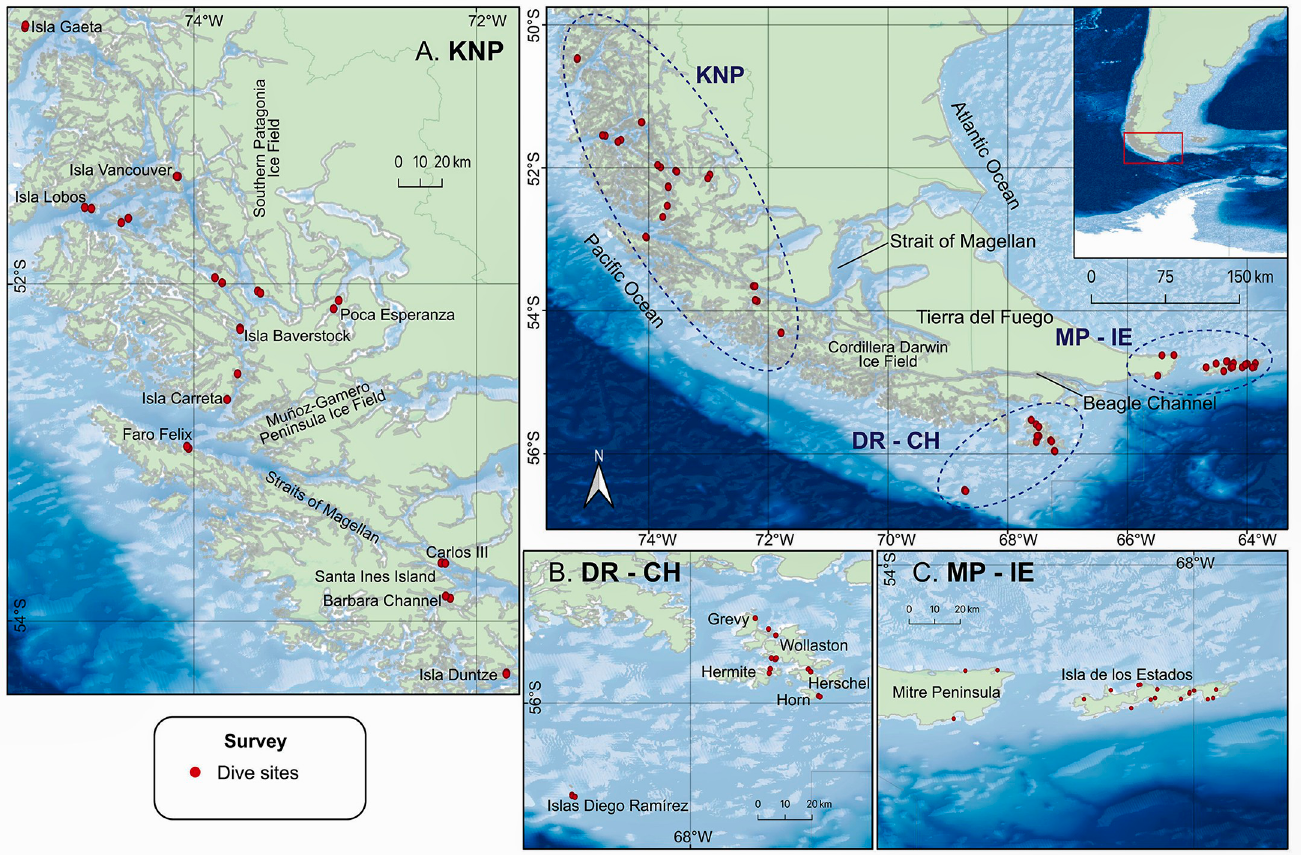
Fig 1. Sampling stations in Southern Patagonia. A. KNP = Kawe´sqar National Park, B. DR = Diego Ramı´rez and CH = Cape Horn Archipelago, C. MP = Mitre Peninsula and IE = Isla de los Estados. Basemap derived from GEBCO Compilation Group (2020) GEBCO 2020 Grid (doi:10.5285/a29c5465-b138-234de053- 6c86abc040b9). Processing and assembly of the Global Self-consistent, Hierarchical, High-resolution Geography Database for shoreline data from [35].